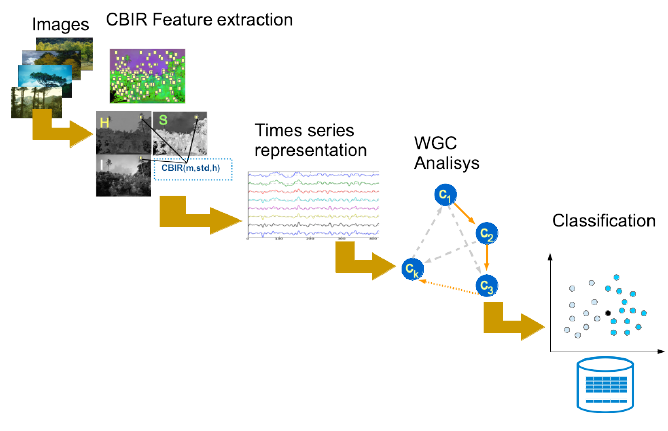
Figure 1. Proposed general